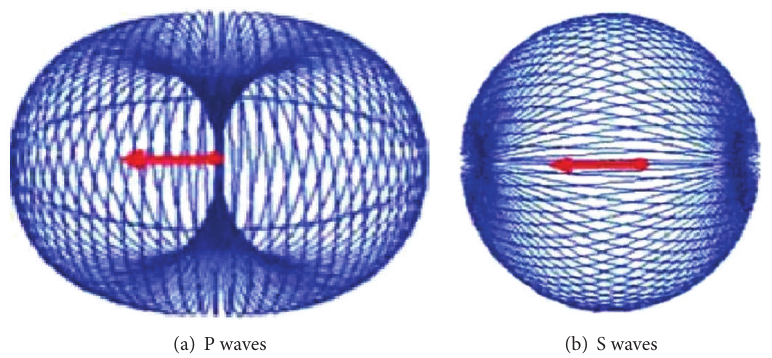
Figure 1: Diagrams of waves propagation from concentrated force.